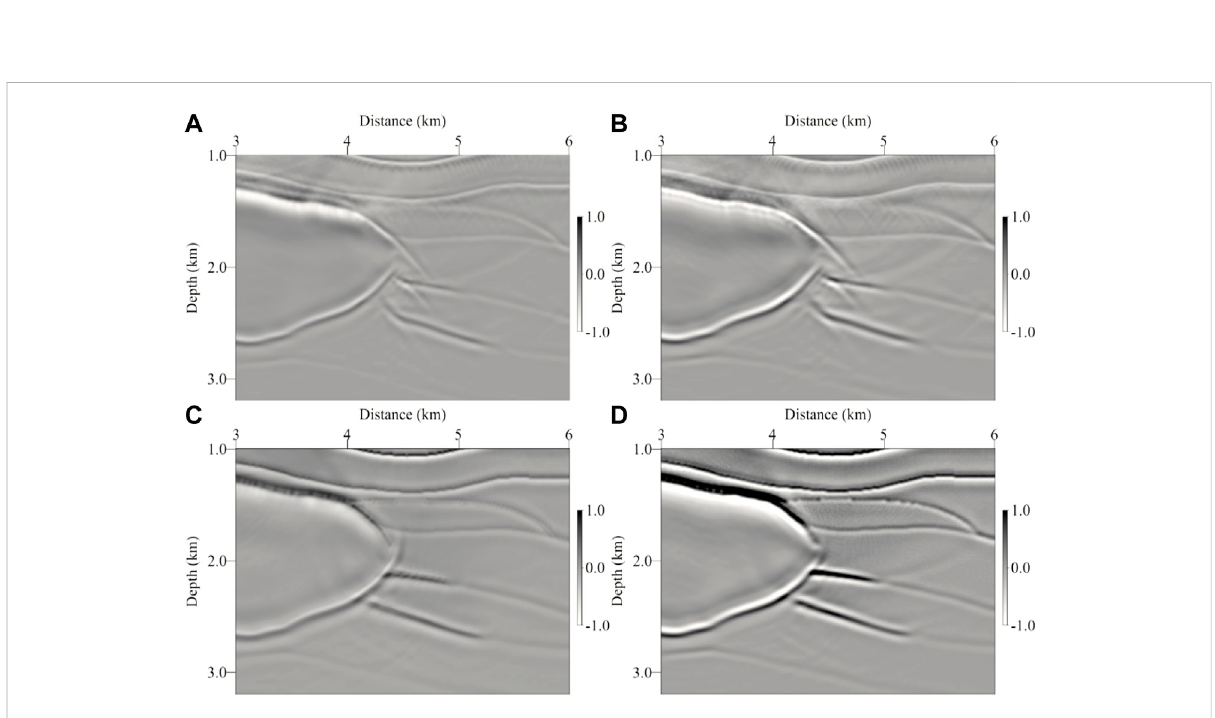
Zoomed views of LSRTM images shown in Figure 10. (A) LSRTM image, (B) viscoacoustic LSRTM image, (C) VTI LSRTM image, and (D) viscoacoustic VTI LSRTM image. And the color scales of all the images are the